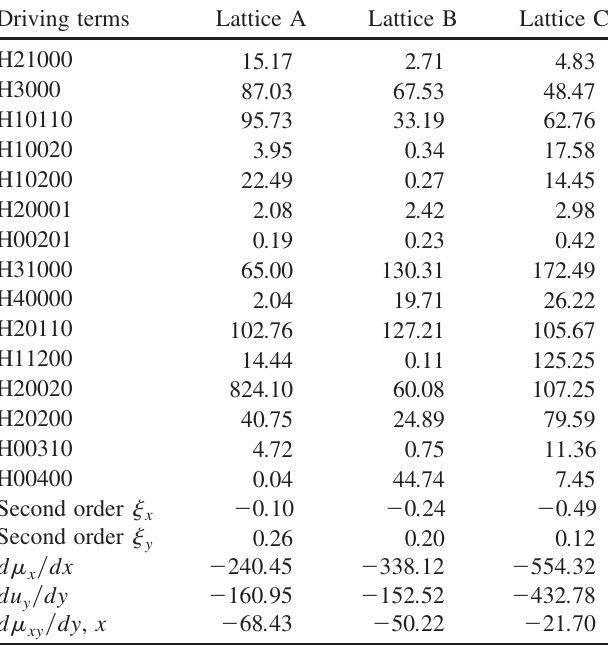
TABLE II. The nonlinear driving terms for some of the Pareto optimal solutions.